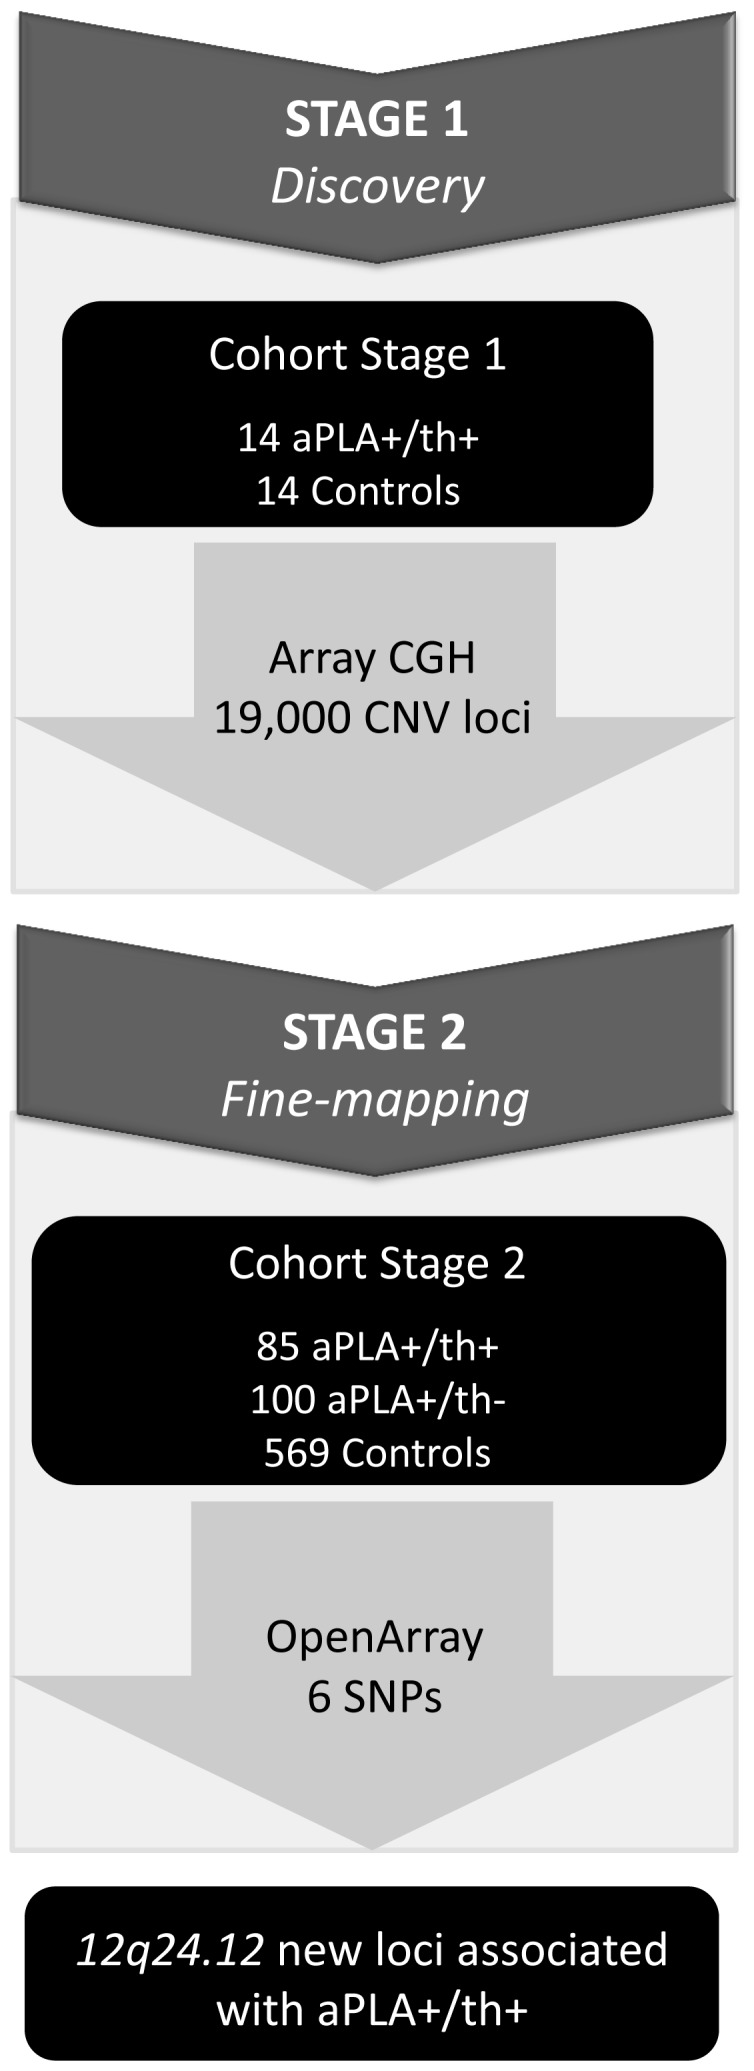
Overview of study design.